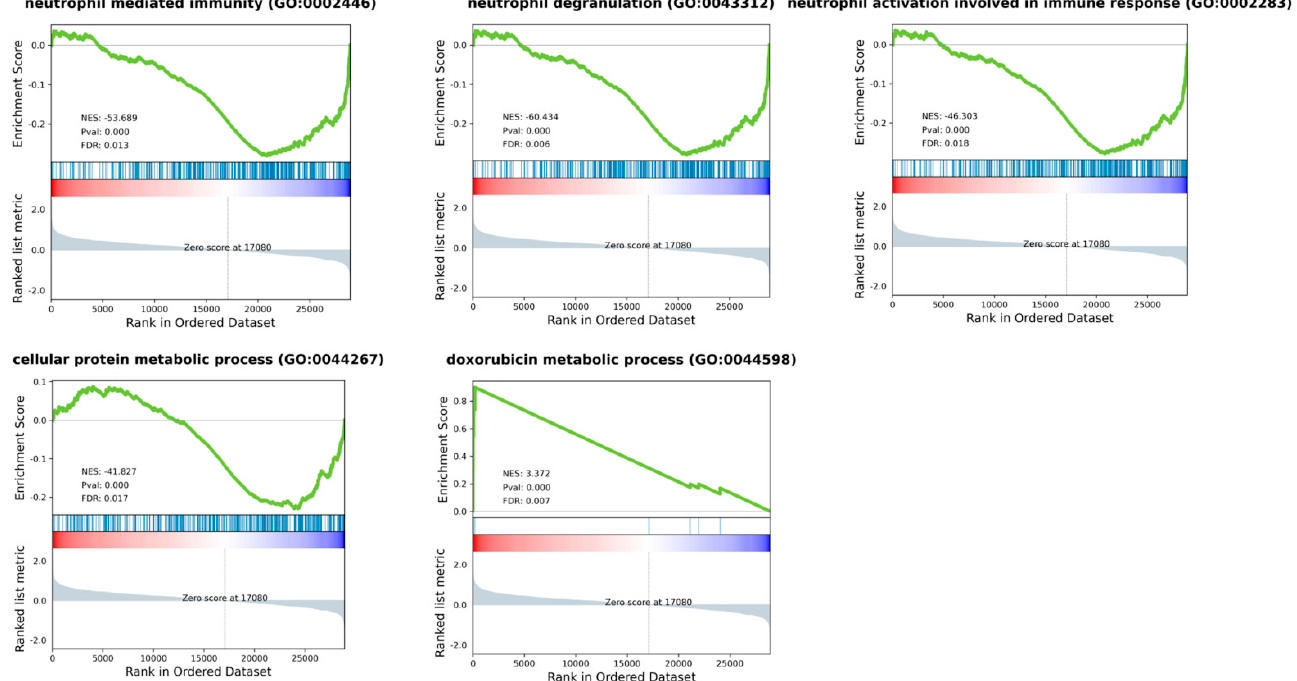
Figure 4. Gene Set Enrichment Analysis (GSEA) plots for most representative enriched pathways of Gene Ontology Biological Process, when comparing MFS vs. UPS patients. Most dysregulated pathways were neutrophil activation, degranulation, and mediated immunity, as well as cellular protein and doxorubicin metabolic processes. Green line shows enrichment profile, red and blue bar represents the position of the gene set enrichment at the top (red) or bottom (blue) of the ranked list.